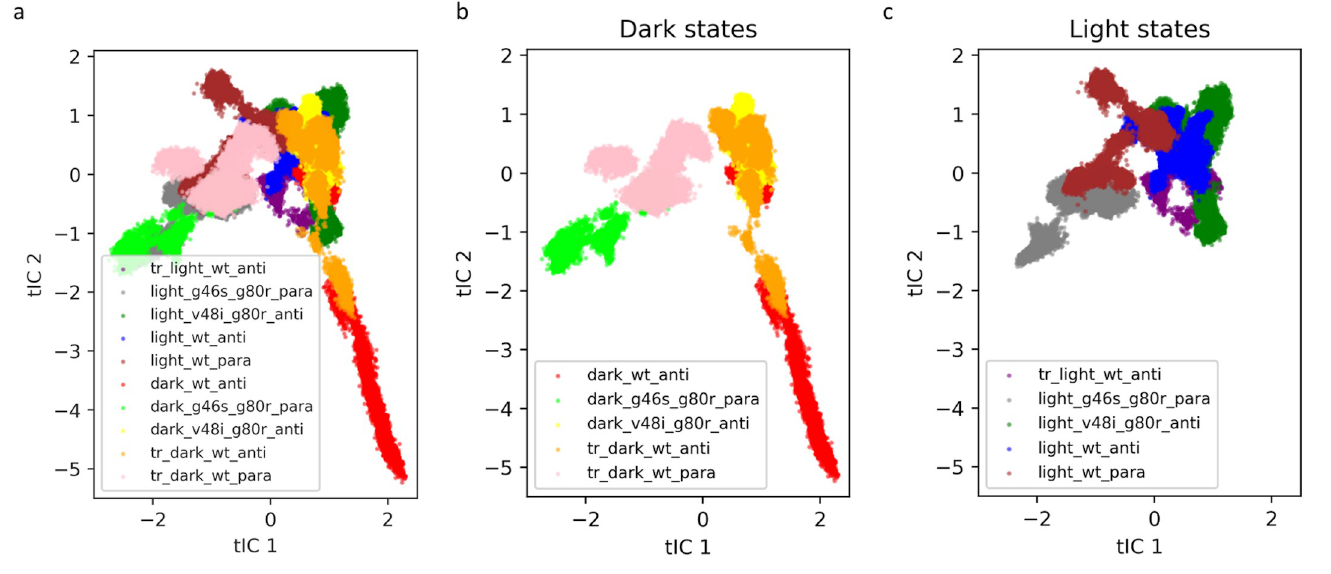
Fig 7. Dimensionality reduction analysis using tICA method. a) All structures. b) Dark states including the dark native anti-parallel and the transient dark states. c) Light states including the light native parallel and the transient light states.